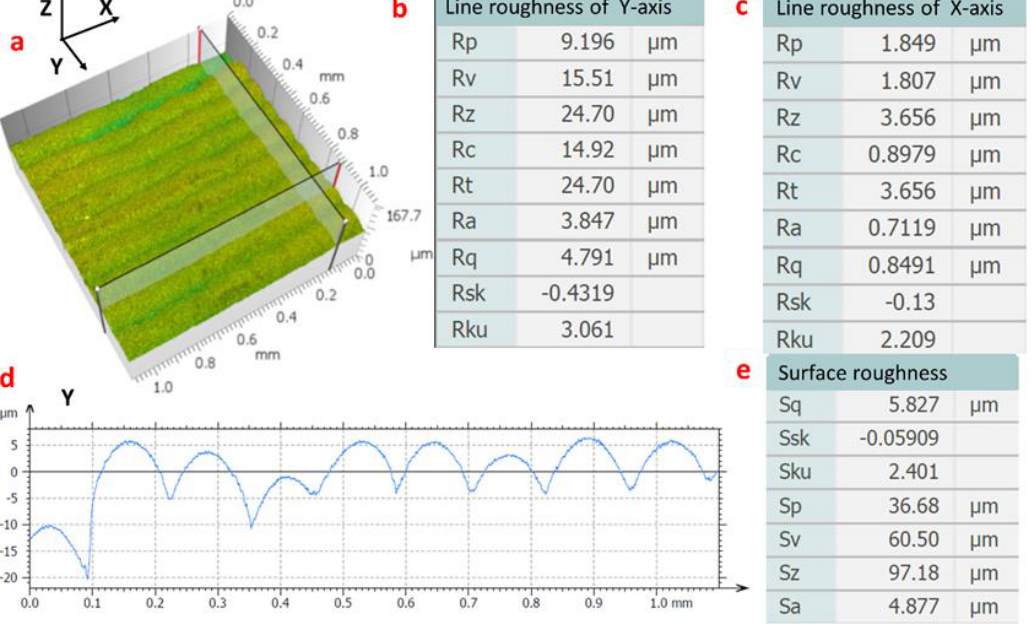
Figure 7. Surface roughness of LJWF-DMD thin-walled part. ( a ) 3D confocal microscopy images. ( b ) Line roughness along Y -axis. ( c ) Line roughness along X -axis. ( d ) Surface contour extracted in the printing direction. ( e ) Specimen surface roughness. Table 5. Comparison of the proposed LJWF-DMD process with some research works from the literature.